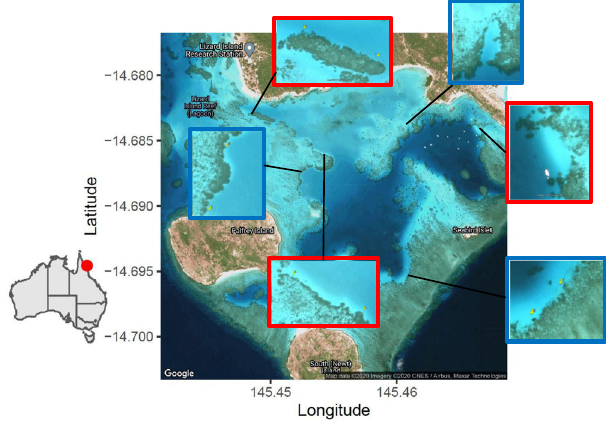
Fig. 5 Map of the experimental sites. Red sites were ‘ busy-boating ’ areas while blue sites were ‘ limited-boating ’